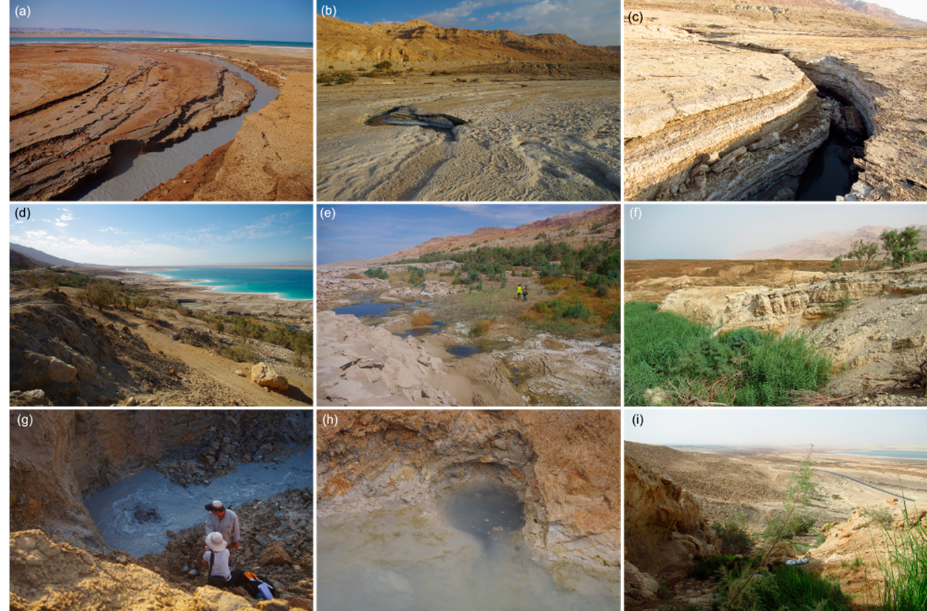
Figure 9. Highlight area—different types of channels, canyons, springs, and vegetation: ( a ) mean- dering stream channel near the mouth at the DS, ( b ) view of a meandering channel inside salt and mud cover with a more detailed view in ( c ), ( d – f ) vegetation and water ponds along the shoreline, ( g ) karstic spring at the mud − alluvium interface [29], ( h ) sulfur-rich spring in mud, and ( i ) spring and vegetation in the uphill part of a wadi. All photos were taken by Djamil Al-Halbouni. Evaporite minerals and salt formations.